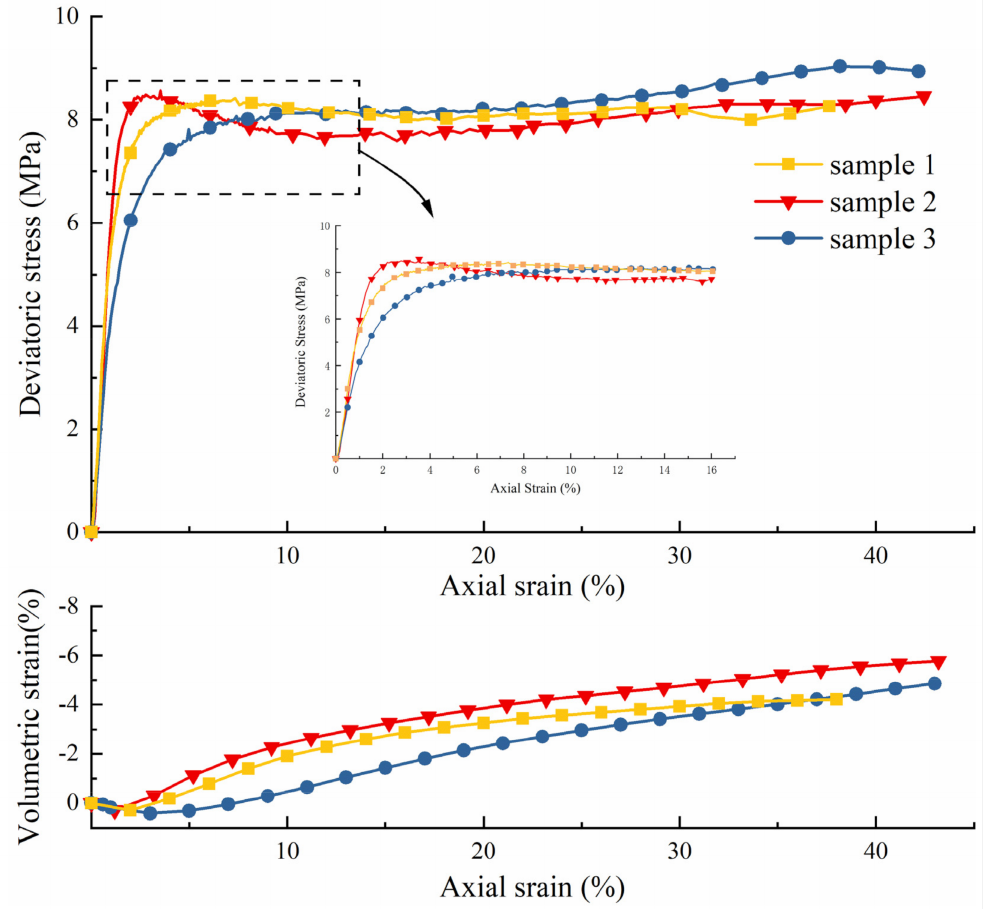
Figure 3. The stress-strain curves and volumetric strain curves of the